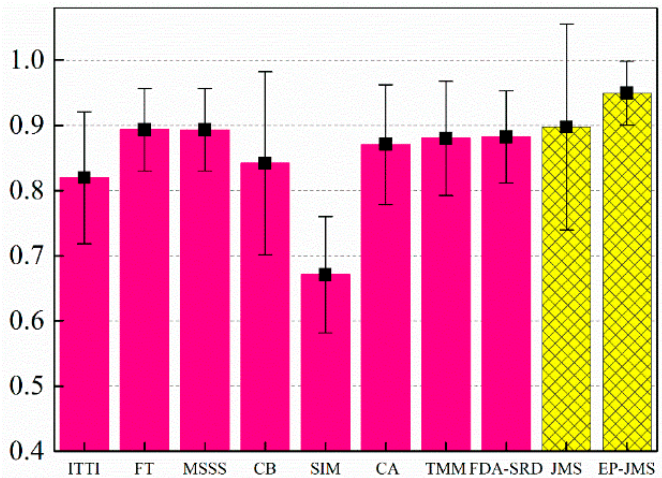
Figure 16. Accuracy and corresponding standard deviation.